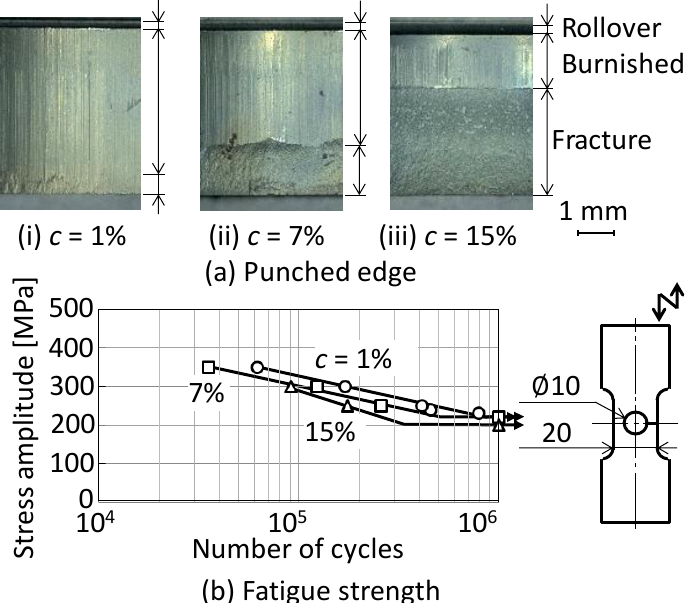
Figure 4. Surfaces of sheared edge and fatigue strength for punched ultra-high strength steel plate for ( a ) punched strength and ( b ) fatigue strength